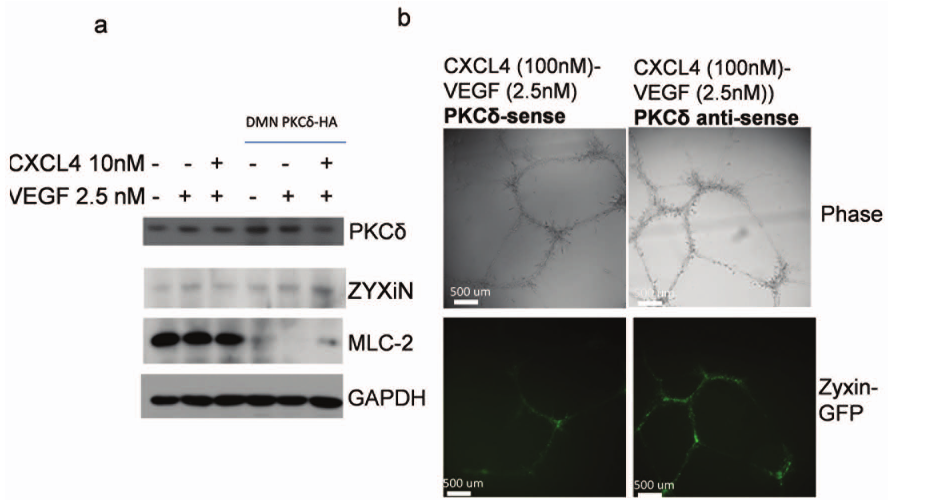
Figure 5. The tension-sensor zyxin is elevated in the absence of PKC d . a) Immunoblot of HMEC monolayer transfected with Dominant negative PKC d DNA vector (4 ug/lipofectamine[10 ul]) prior to treatment with CXCL4/VEGF in quiescence media for 24 hours. b) Live cell fluorescent images of Zyxin-expressing HMEC cells that have formed cords. After cords were formed, cells were incubated for 5 days with 20 uM PKC d -sense or PKC d -anti-sense in VEGF 2.5 nM/CXCL4 100 nM. Shown are representative of 3 experiments.